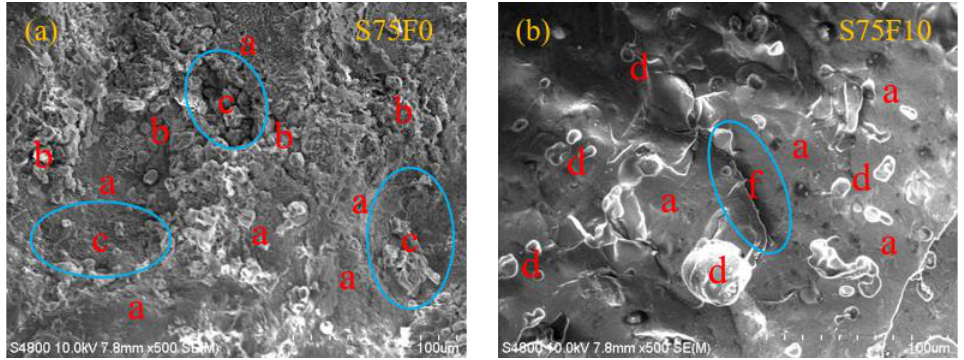
Figure 14. Micromorphology of specimens under SEM (400×) ( a ) S75F0; ( b ) S75F10: a = plate crystallization; b = chain crystallization; c = flaw; d = fly ash; f = crack.